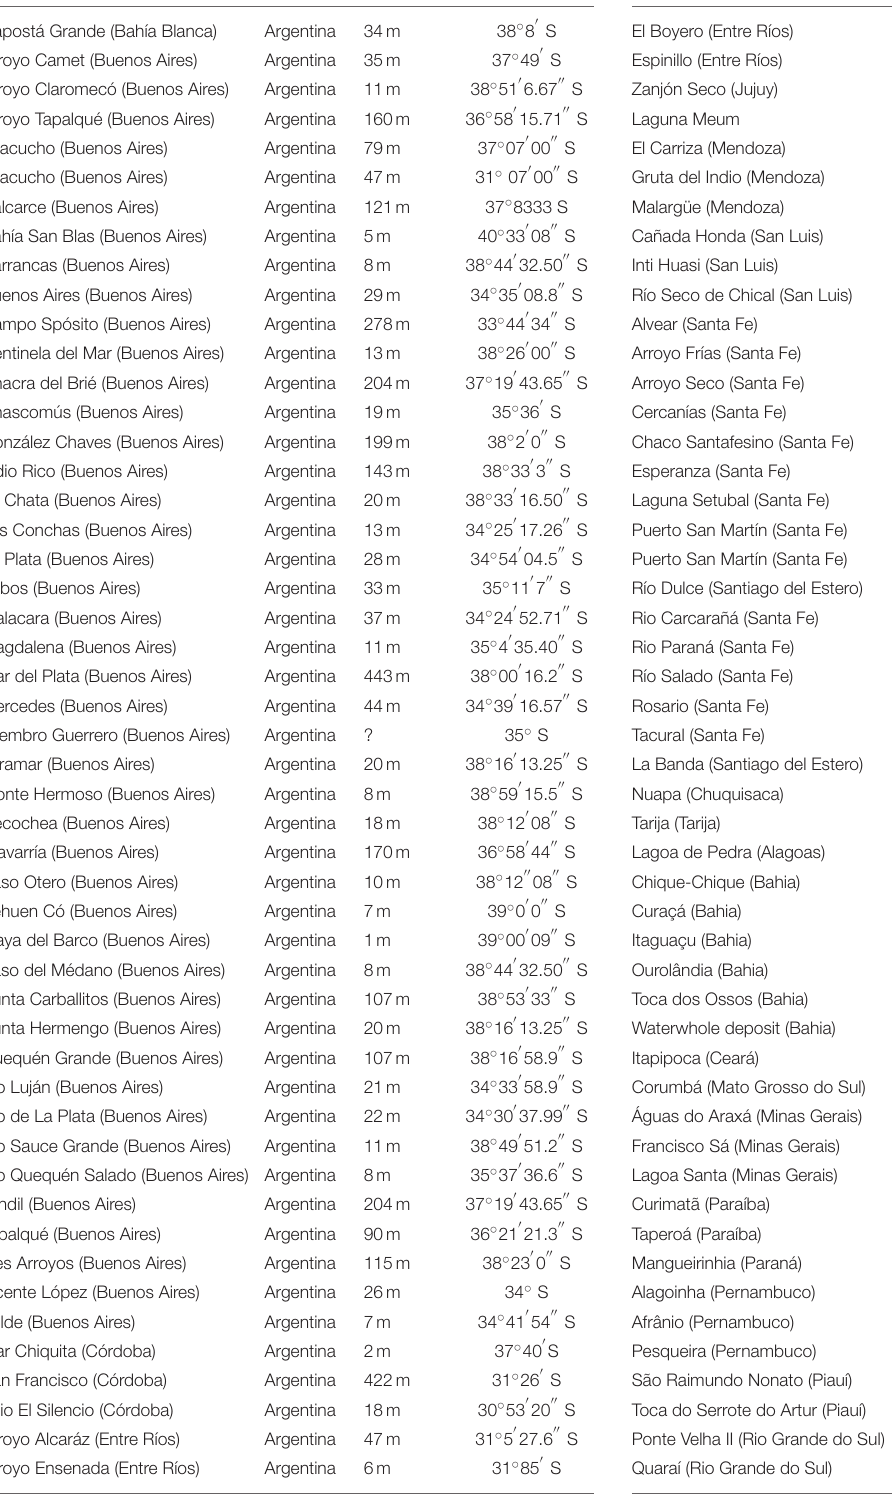
TABLE 4 | Locations and altitudes of Equus fossil occurrences in South America. Localities